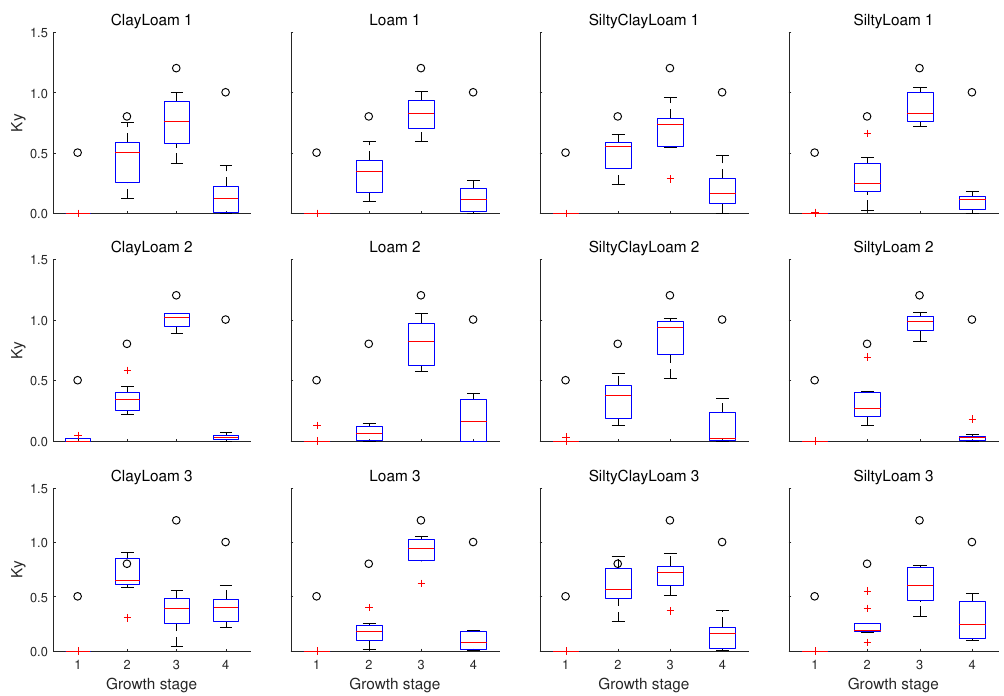
Figure 6. Yield response factor ( Ky ) obtained for sugar beet for every soil type, considering the benchmark process. Circles represent Ky values proposed by the FAO